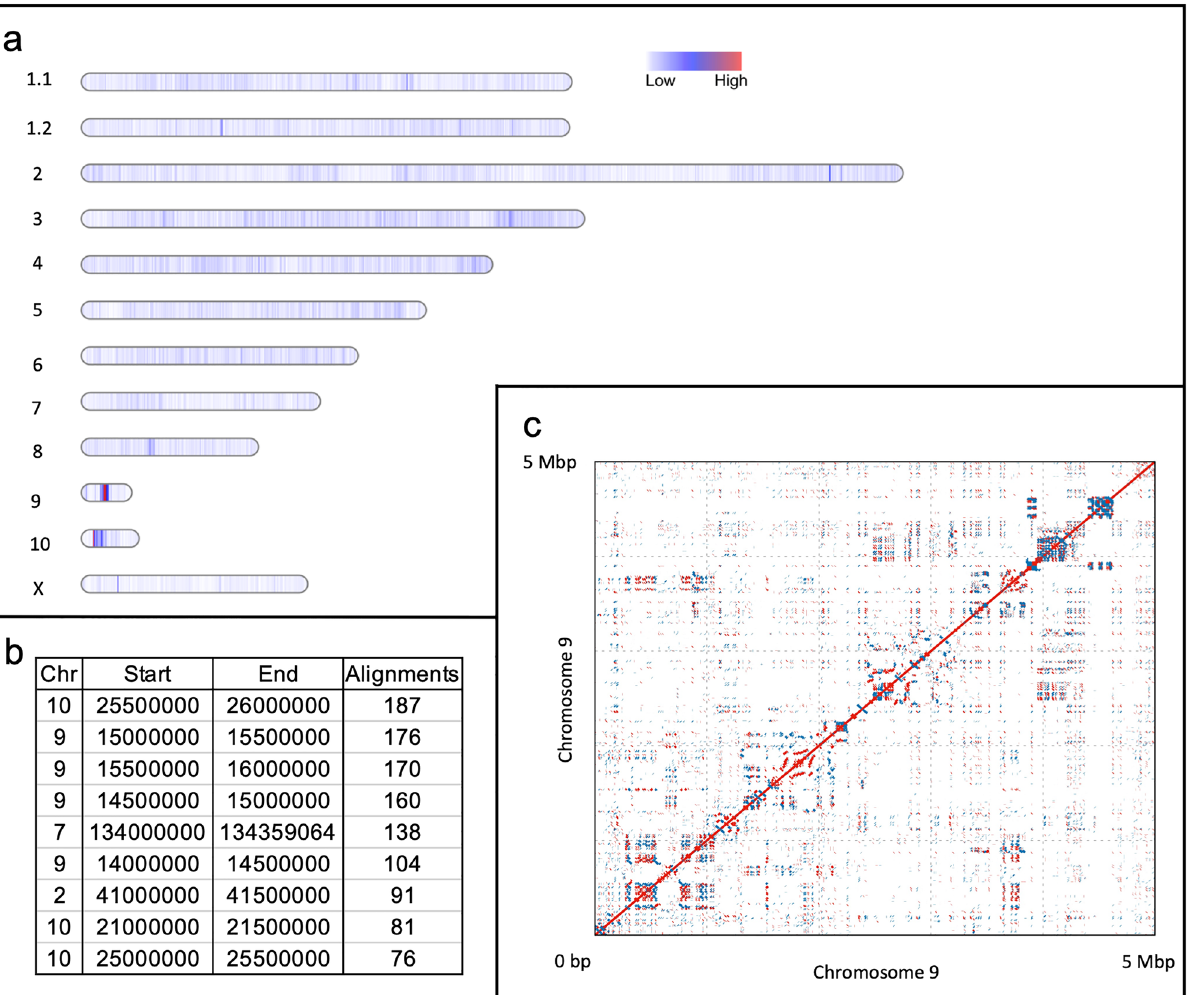
Figure 5. Observed eccDNA biogenesis sites and characteristics. ( a ) Chromosome-scale heatmap of eccDNA sequences observed for the Day 0 samples. Frequency of observed eccDNA is shown in color; low (white) to high (red). Figure made with minimap2 48 and bedtools 47 . ( b ) 500 kbp windows with the highest eccDNA mapping frequencies (Top 10 from Day 0 only). ( c ) Self-alignment of chromosome 9 biogenesis hot spot. Red lines indicate a direct repeat; blue lines indicate an inverted repeat. Plot made using Mummer 65